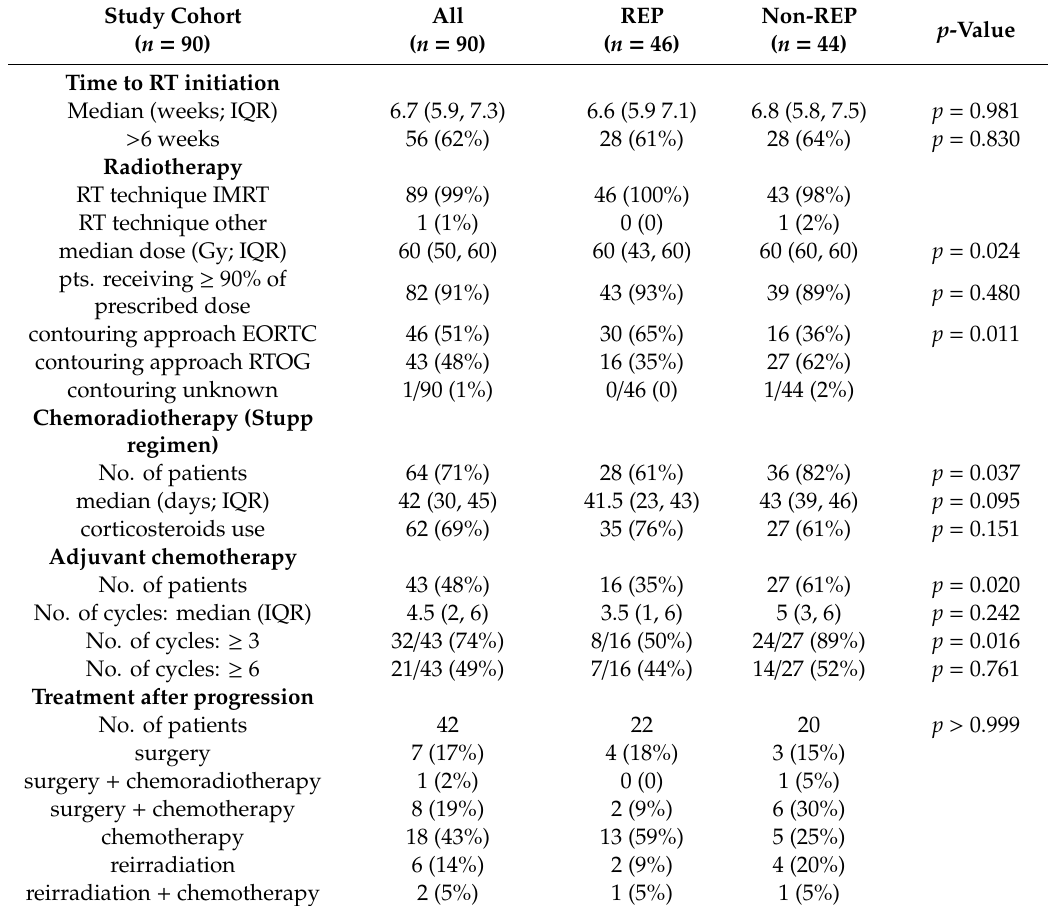
Table 2. Patients’